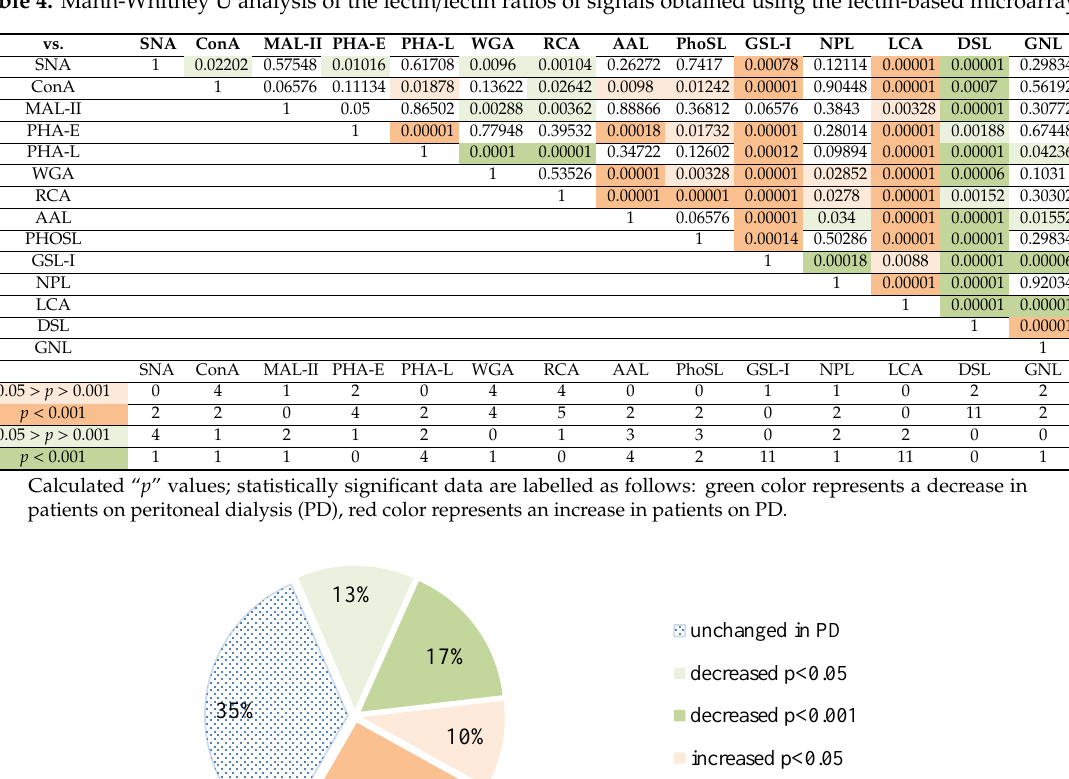
Table 4. Mann-Whitney U analysis of the lectin/lectin ratios of signals obtained using the lectin-based microarray.